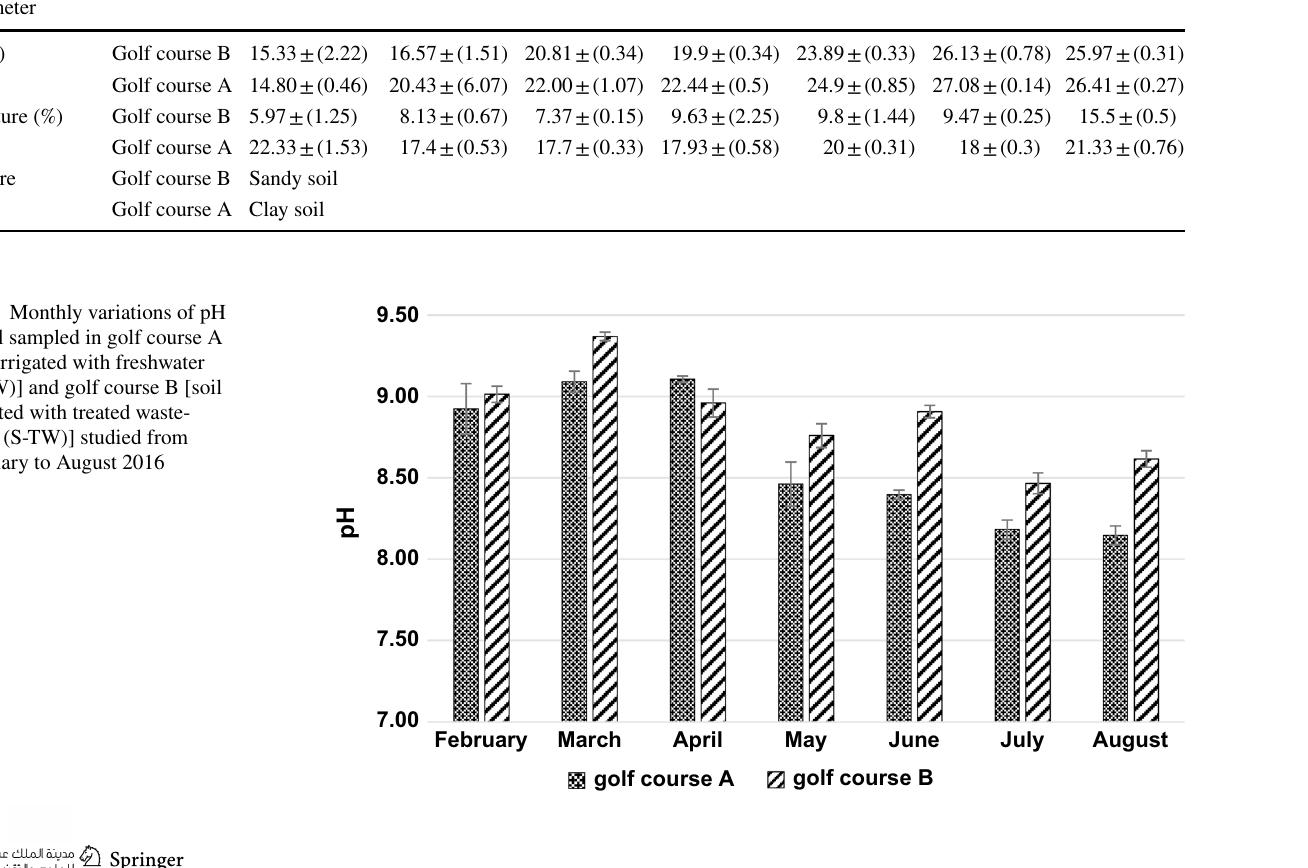
Table 2 Main physical soil characteristics (mean values and standard deviation) Measured parameter